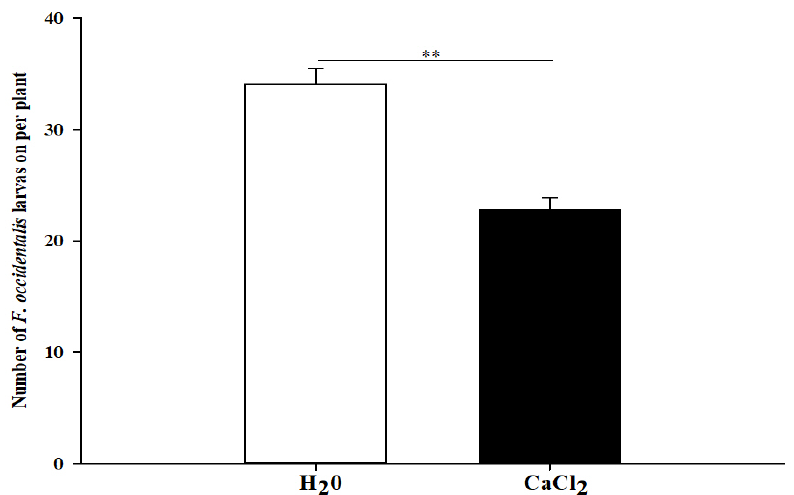
Figure 2. Means (± SE) represent the number of F. occidentalis larvae on H 2 O and exogenous calcium- treated kidney bean plants 48 h after oviposition of female F. occidentalis . ** indicate high significant difference at 1% level.